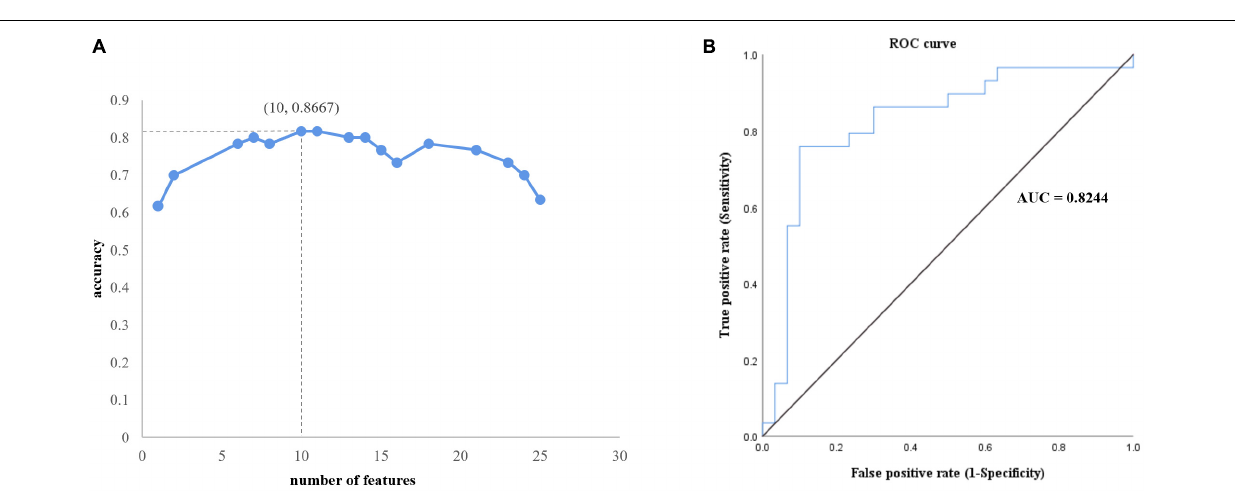
FIGURE 3 | Performance of the proposed analytical framework. (A) Ten features corresponding to best classification accuracy. (B) The receiver operating characteristic curve. The area under the curve is 0.8244, which indicates outstanding